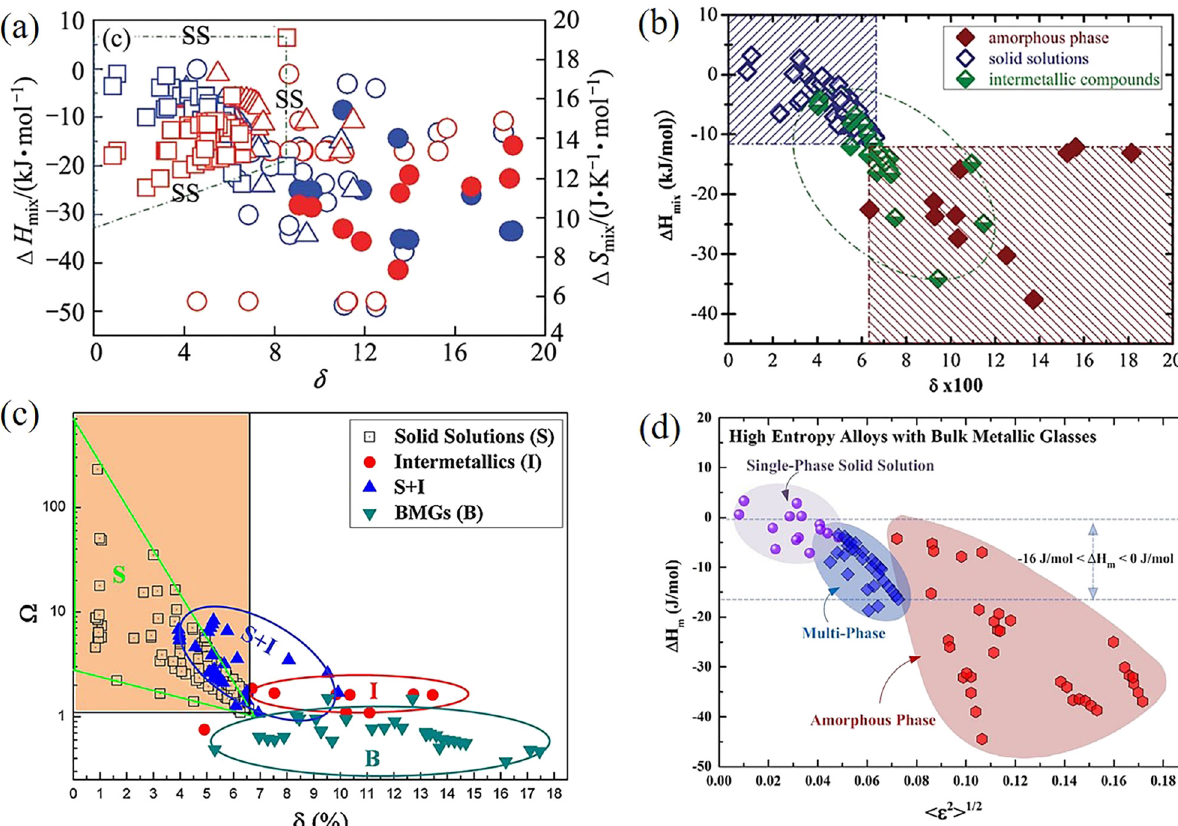
Figure 3: Relationship between the structure of HEAs and parameters, ( a ) superimposed e ff ect of Δ H mix , δ and Δ S mix [ 9 ] , ( b ) superimposed e ff ect of Δ H mix and δ [ 77 ] , ( c ) superimposed e ff ect of Ω and δ [ 74 ] , ( d ) superimposed e ff ect of Δ H m and < ε 2 > 1/2 (< ε 2 > 1/2 is the residual strain, which is related to δ ) [ 82 ]